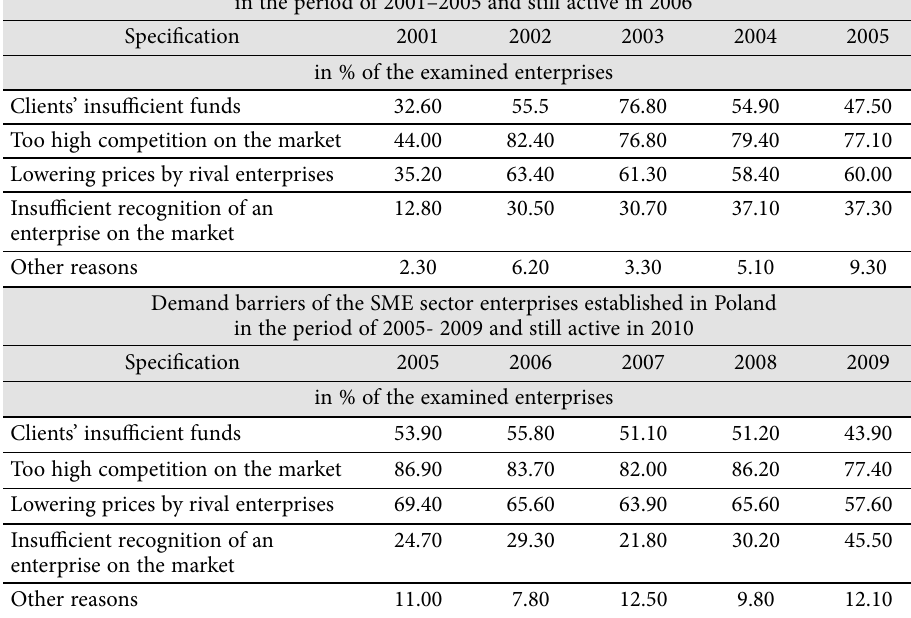
Table 2. Demand barriers of the SME sector enterprises established in Poland in the period of